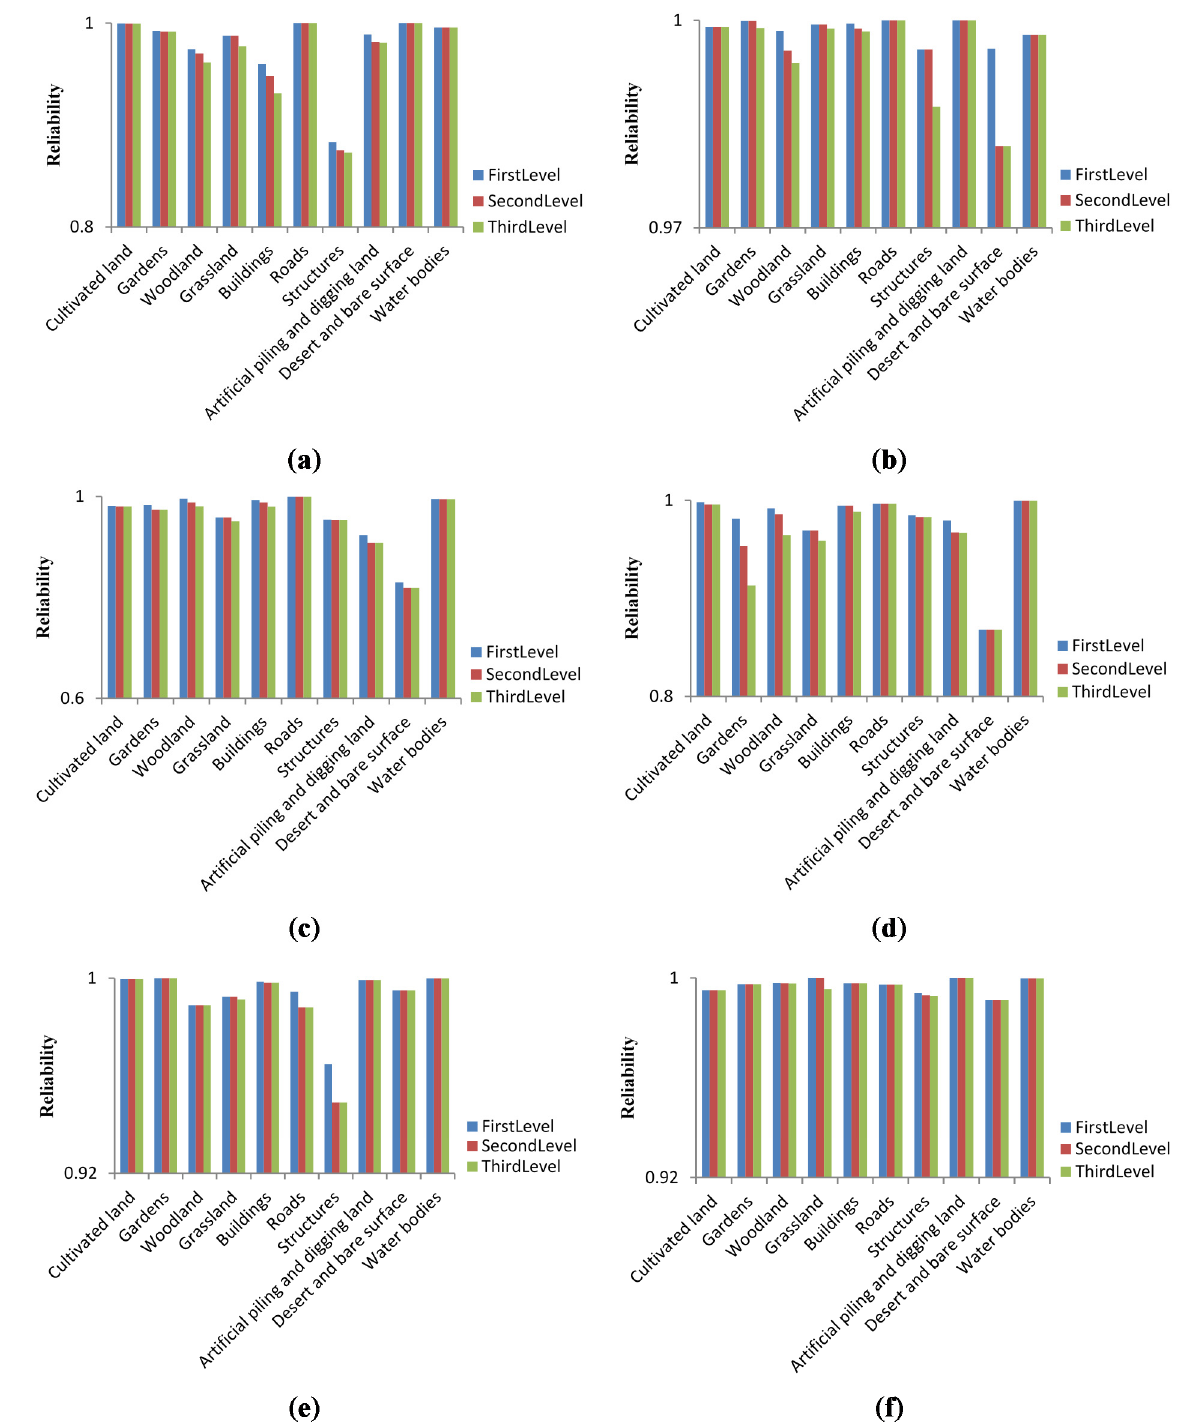
Figure 5. Classification correctness of first-level types in the six study areas: ( a ) County 1; ( b ) County 2; ( c ) County 3; ( d ) County 4; ( e ) County 5; and ( f ) County